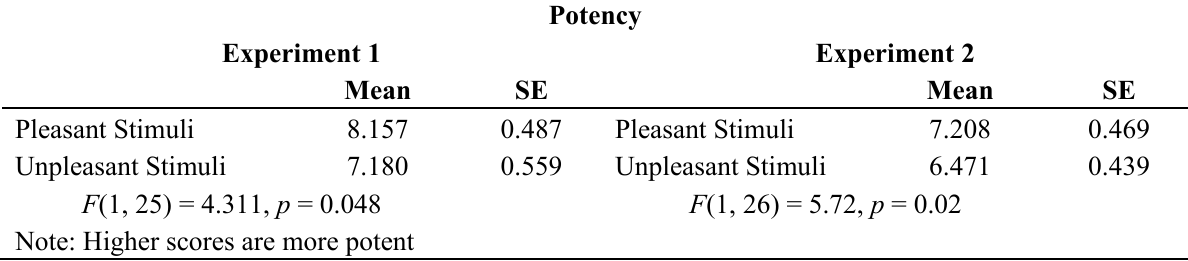
Table 1. Visual Analog Scale mood means in centimeters for potency, valence, and arousal scales for the second and third stimulus